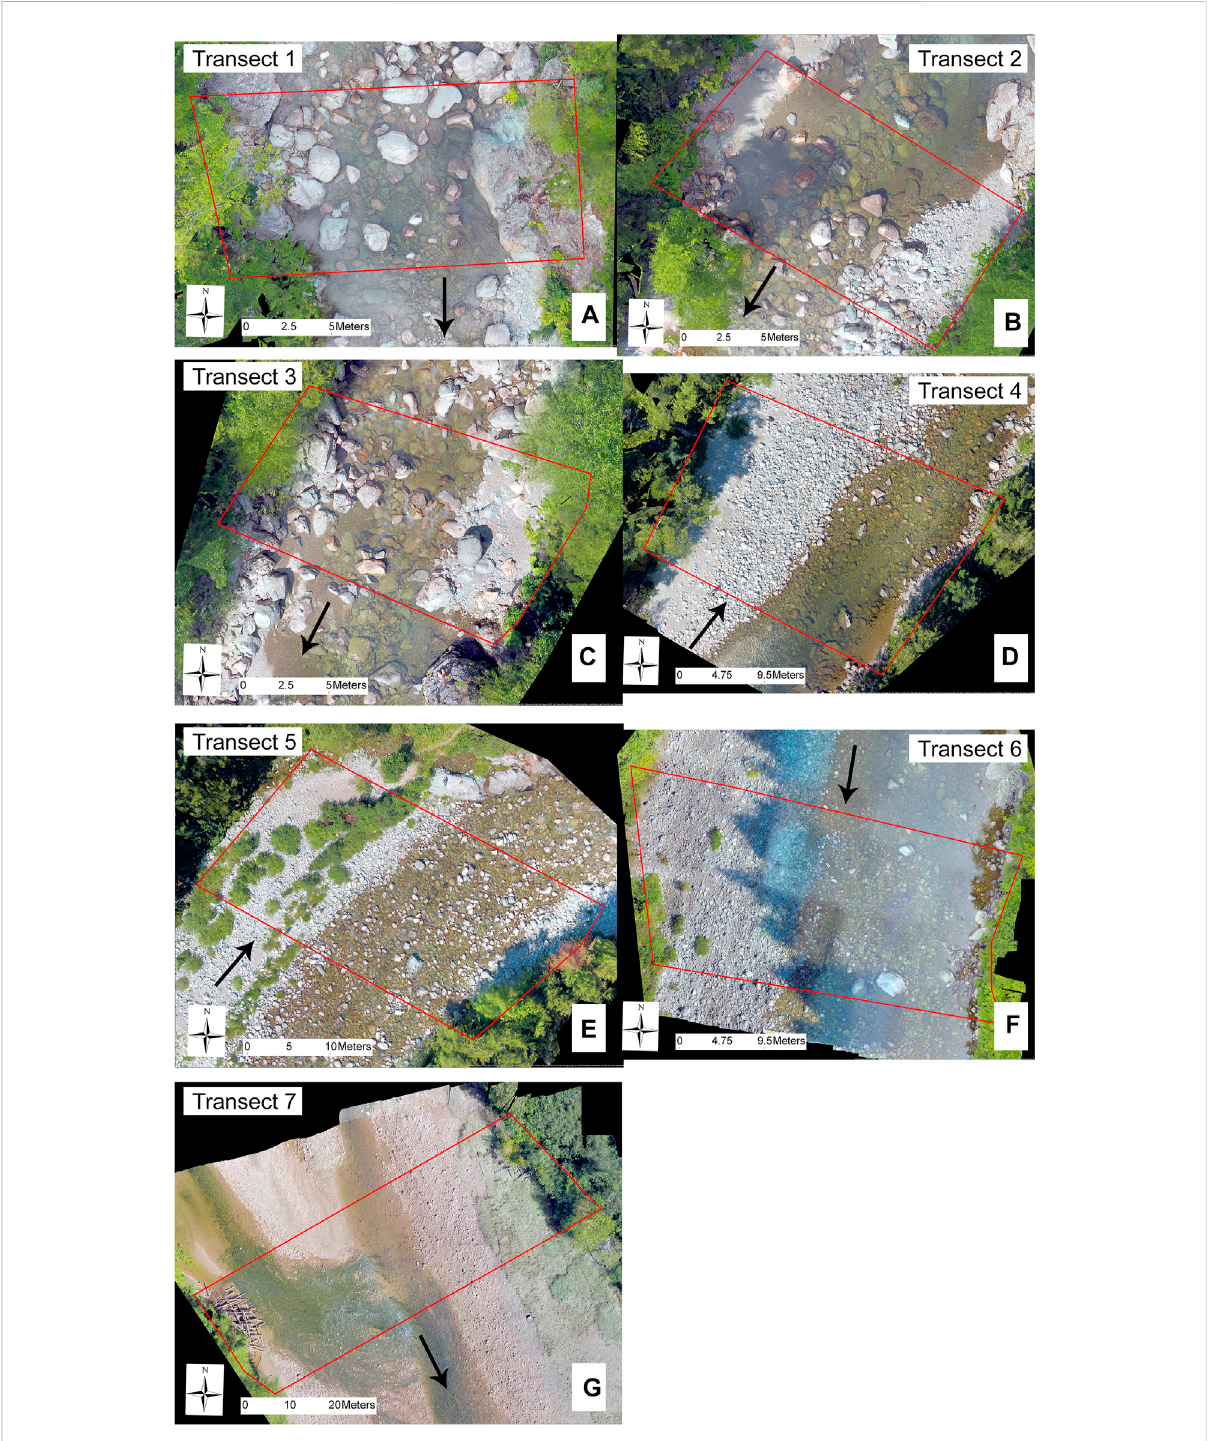
FIGURE 2 Orthomosaicsfortransects1 – 7,transectareasdenotedbytheredboxes,withblackarrowstoindicatedownstream fl owdirection. (A)